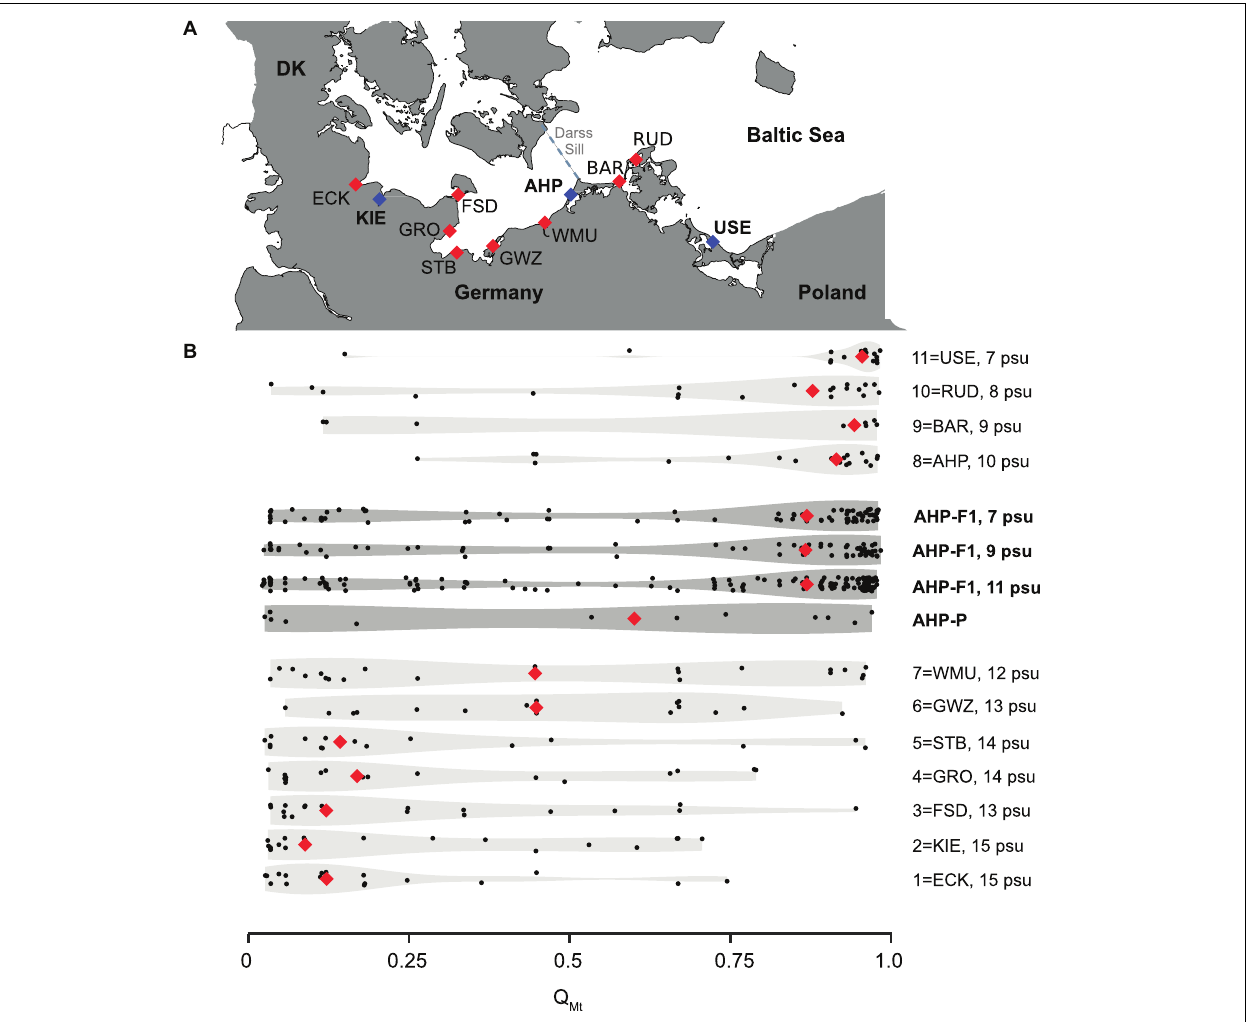
FIGURE 1 | Distribution of Baltic Mytilus species and sampling localities. (A) Sampling locations for the population comparison (Kiel, KIE; Usedom, USE) and the desalination (Ahrenshoop, AHP) experiments. Further references locations for genetic analyses are shown ECK, Eckernförde; FSD, Fehmarnsund; GRO, Grömitz; STB, Steinbeck; GWZ, Gollwitz; WMU, Warnemünde; BAR, Barhöft; RUD, Rügen Island (Dranske); USE, Usedom (see further information in Supplementary Figure 5 ). (B) Distribution of hybrid classes expressed as Q MT -values (0 = genotypes dominated by M. edulis alleles, 1 = genotypes dominated by M. trossulus alleles). Experimental data (dark grey, animals sampled in 2016 in AHP, parental animals: AHP-P, larval offspring populations: AHP-F1 and reference data from Stuckas et al. (2017) (light grey, animals sampled in 2013, including average salinity values) are given as violin plots. Median Q MT values are indicated by red diamonds. Compare to Supplementary Figure 3 for full dataset and STRUCTURE bar plots. Salinity is given for each locality based on hydrodynamic model data obtained from Stuckas et al.